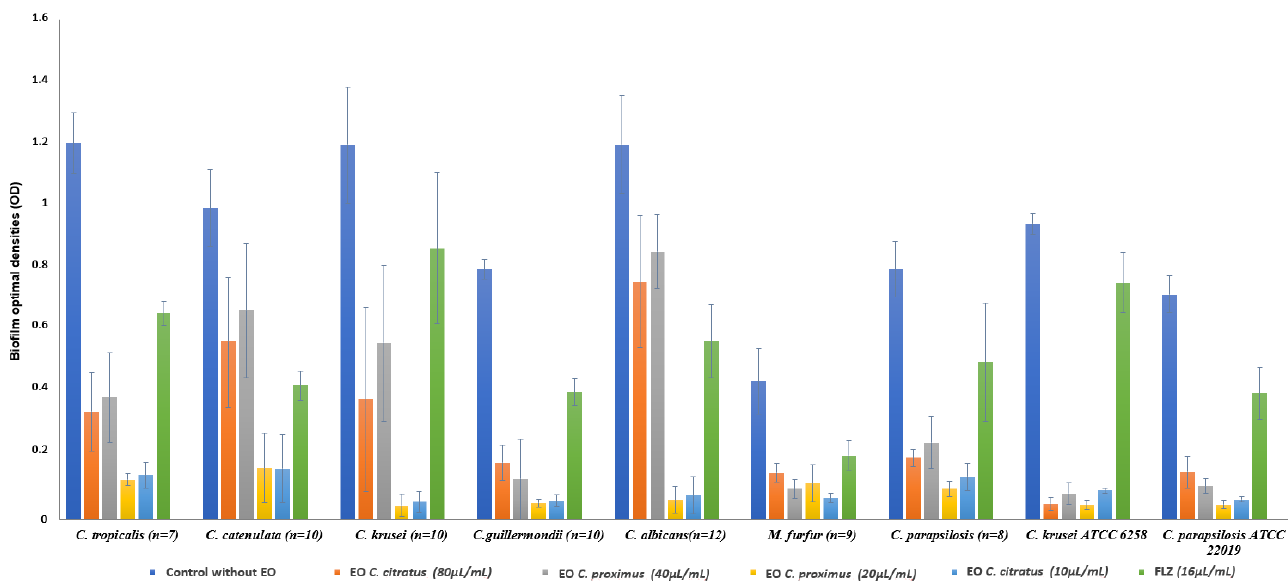
Figure 3. Absorbance of Candida spp. and M. furfur biofilm with and without C. citratus , C. proximus EOs and FLZ. C. citratus and C. proximus EOs were tested at different concentrations. The antibiofilm effects of both EOs were not related to their concentrations. The C. Table 4. Percentage of Candida spp. and Malassezia furfur biofilm inhibition by C. proximus and C. citratus EOs at different